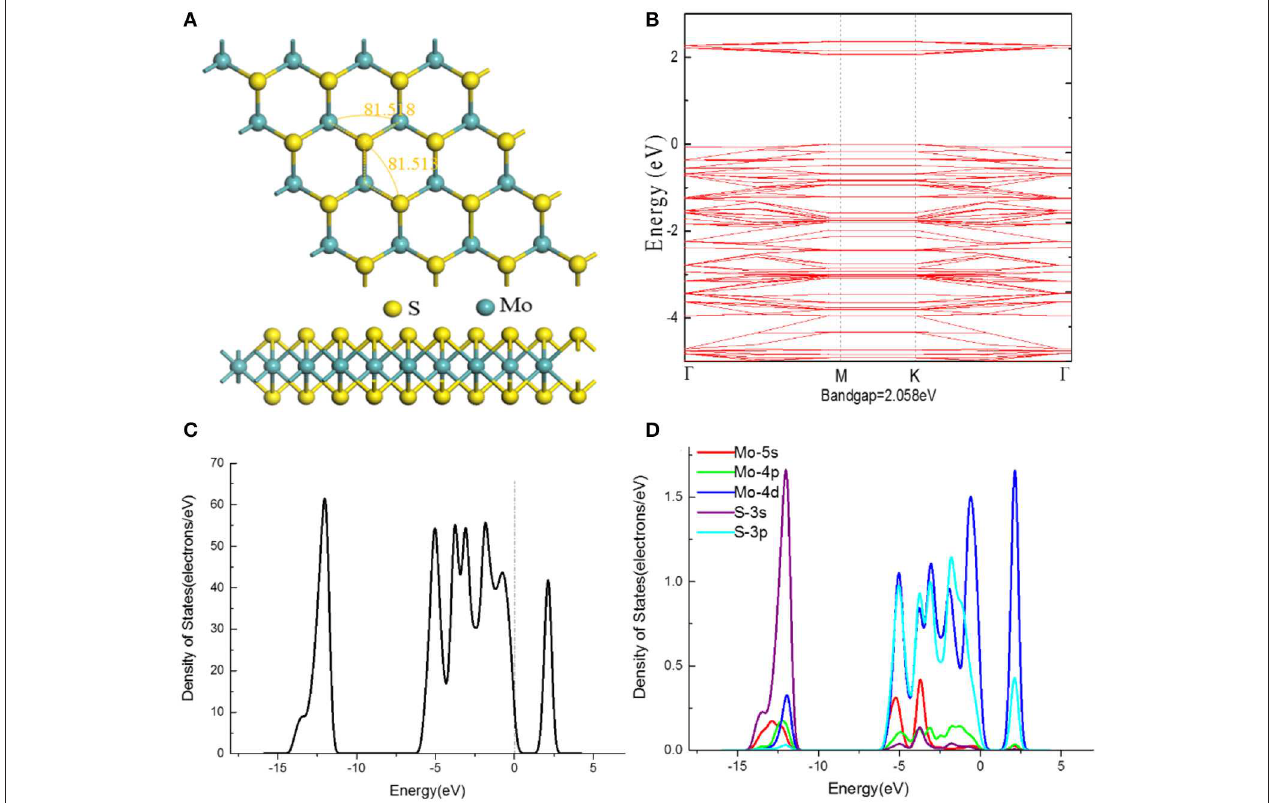
FIGURE 2 | (A) The structures, (B) Band structures, (C) TDOS, and (D) PDOS of MoS 2 monolayer.